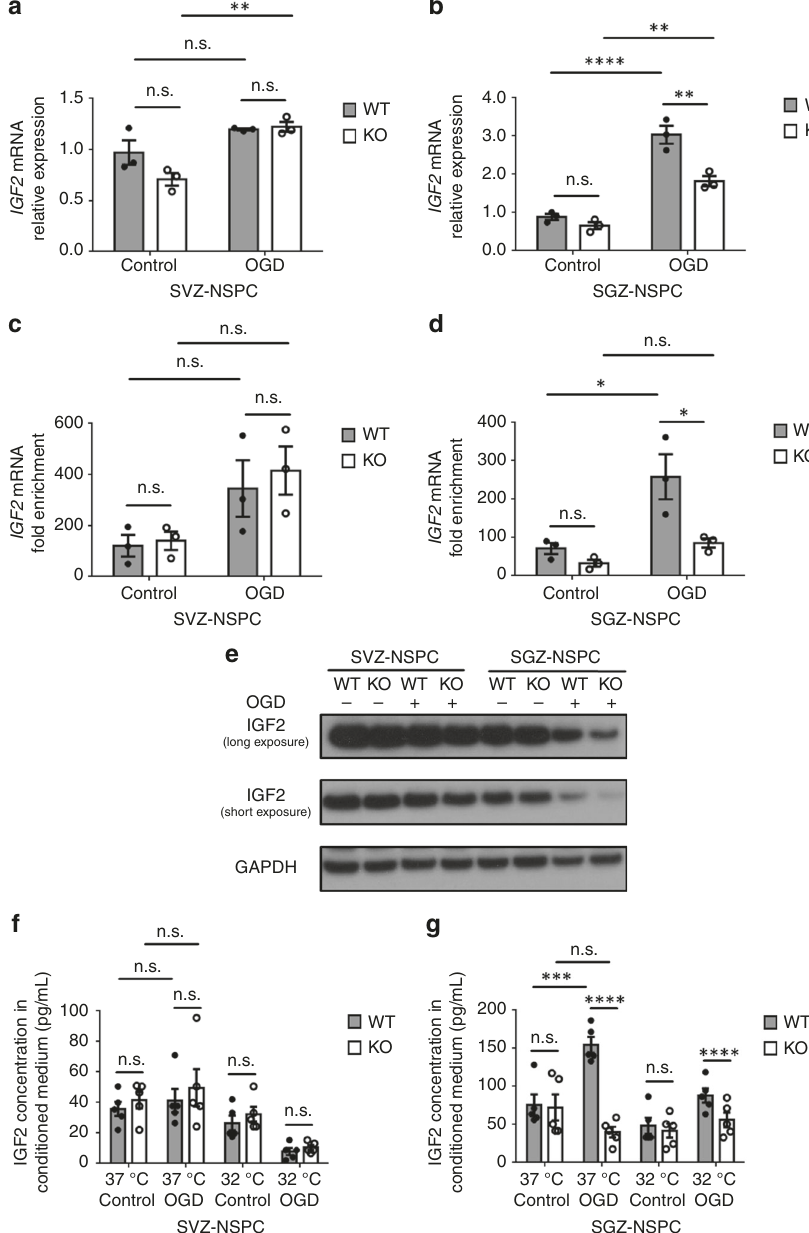
Fig. 6 RBM3 regulates IGF2 expression in SGZ- but not SVZ-NSPCs in vitro. a , b Quantitative RT-PCR of IGF2 mRNA expression in SVZ-NSPC ( a ) and SGZ- NSPC ( b ) after 3 h OGD and 3 h reoxygenation in the presence or absence of RBM3 (three independent experiments, n = 3). IGF2 mRNA level was normalized to GAPDH by 2 − ΔΔ CT method. Two-way ANOVA was used for statistical analysis; n.s. not signi fi cant; ** p < 0.01; **** p < 0.0001. c , d The abundance of bound IGF2 mRNA to IMP2 protein in RBM3 WT or KO NSPCs after 3 h OGD and 3 h reoxygenation. Lysates from SVZ-NSPC ( c ) or SGZ- NSPC ( d ) were subjected to RNA-immunoprecipitation. Anti-IMP2 antibody was used to precipitate IMP2 protein, and the amount of bound IGF2 mRNA was detected by quantitative RT-PCR (three independent experiments, n = 3). Normal mouse immunoglobulin (msIgG) was served as negative control in immunoprecipitation. IGF2 mRNA level was normalized to input by 2 − ΔΔ CT method, and fold enrichment was normalized to msIgG group which was set as 1. Two-way ANOVA was used for statistical analysis; n.s. not signi fi cant; * p < 0.05. e Representative Western blot of IGF2 expression in SVZ-NSPC and SGZ-NSPC after mock or OGD treatment in the presence or absence of RBM3. f , g IGF2 levels in culture medium by ELISA. SVZ-NSPCs ( f ) and SGZ-NSPCs ( g ) were stressed with OGD followed by reoxygenation at 37 or 32 °C for 3 h, then incubated at 37 °C for an additional 21 h. Culture medium was immediately collected for IGF2 measurement by ELISA ( fi ve independent experiments, n = 5). Three-way ANOVA was used for statistical analysis; n.s. not signi fi cant; *** p < 0.001; **** p < 0.0001. All data are presented as mean ± permeabilization and blocking. Samples were incubated with primary antibodies poly-L-lysine coated 16-well chamber slide (Nunc LabTek) and fi xed with 4% PFA for overnight at 4°C. Alexa Fluro dye conjugated secondary antibodies were used in 1:500 10min at RT. To stain BrdU, brain sections or cells were treated with 2M HCl at RT (Thermo Fisher). Nuclei were couterstained with DAPI. Information for primary for 1h and neutralized with 0.1M sodium borate (pH 8.5) for 10min before blocking. antibodies was listed in Supplementary Data 4. 0.5% Trition X-100 and 5% normal goat serum in phosphate buffer was used for